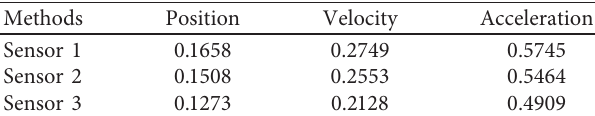
Figure 8: Comparison of distributed weighted fusion estimation results: (a) estimated position state, (b) estimated velocity state, (c) estimated acceleration state, and (d) comparison of MAEs for the position. Table 2: Comparing RMSEs of each